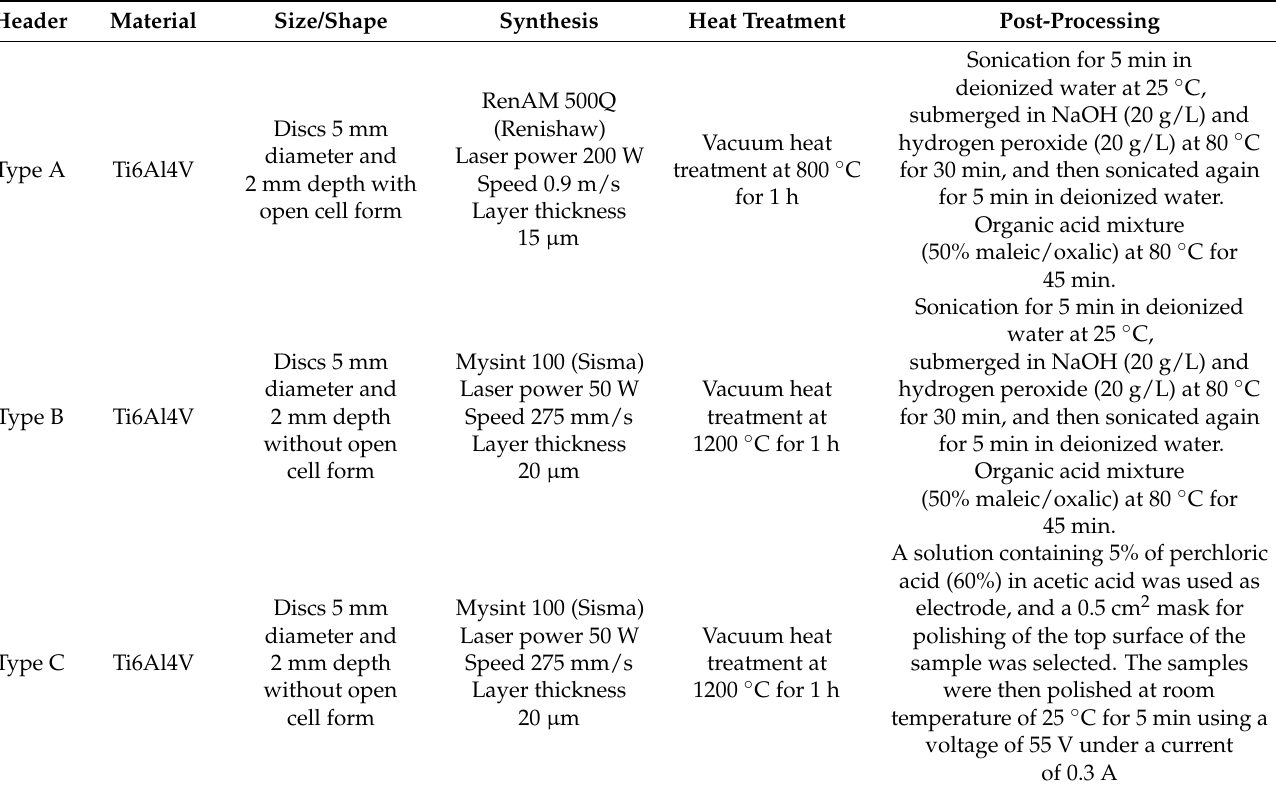
Table 1. Samples parameters and applied post-processing